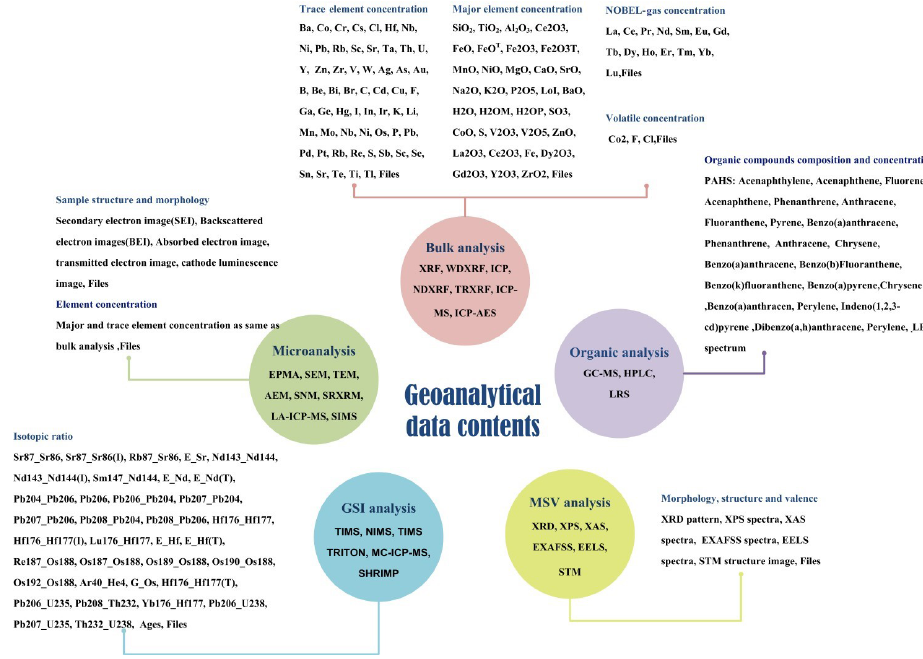
Figure 2. Lists of geoanalytical methods and measurement data items.